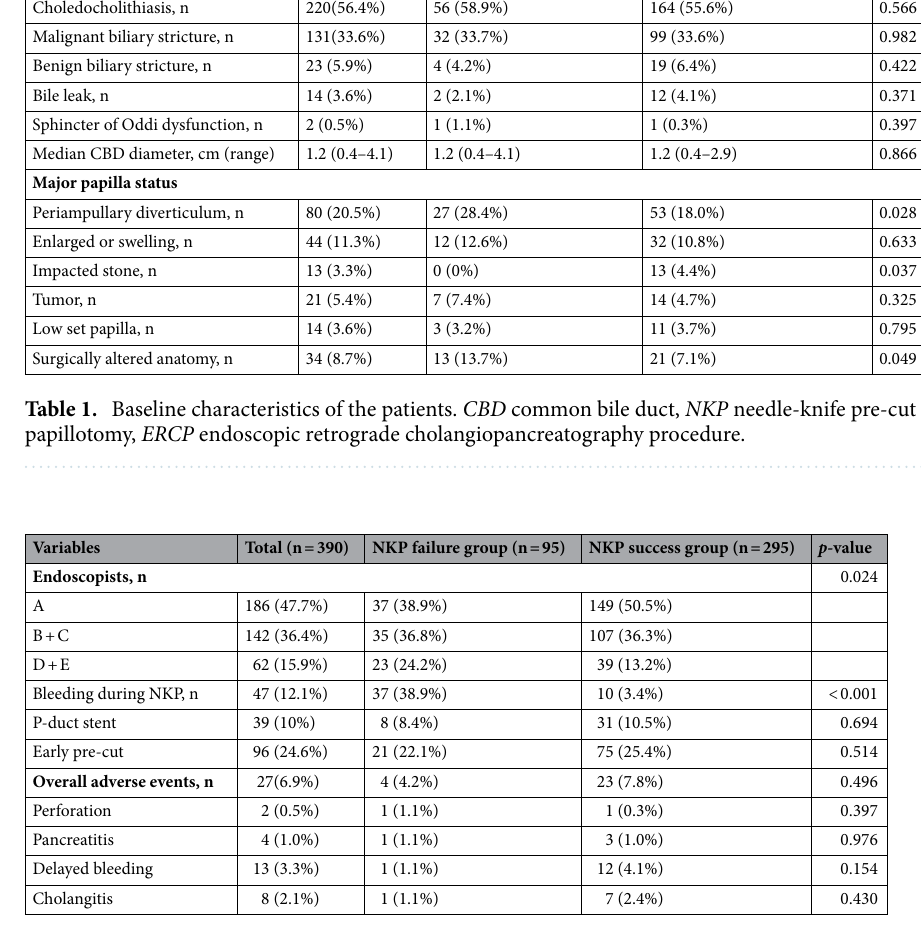
Table 2. Technique factors, and adverse events of needle knife pre-cut papillotomy. NK P needle-knife pre-cut papillotomy, P-duct pancreatic duct.